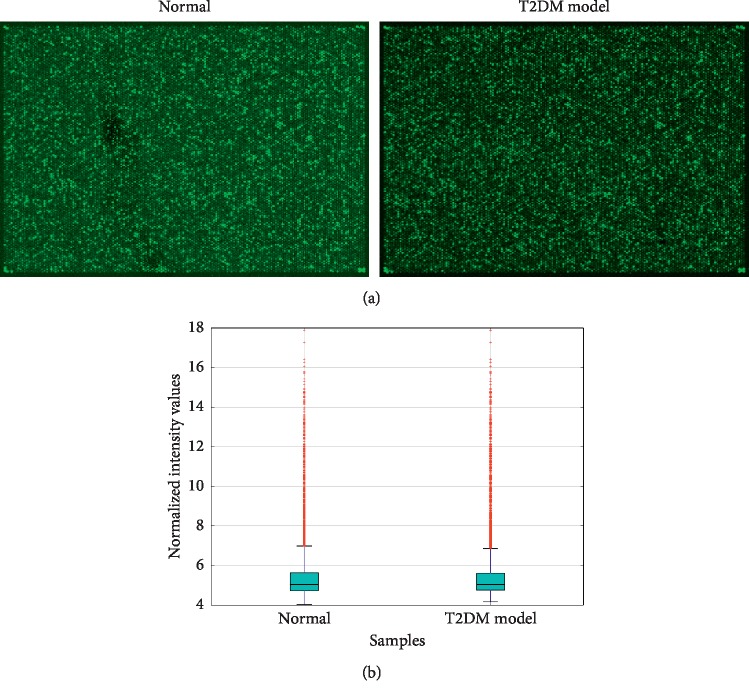
CircRNA microarray expression data between β-cells from normal and T2DM rat islets. (a) The typical results of circRNA microarray from control and T2DM rat islet β-cells. Each bright spot represents a circRNA. (b) Normalized data were plotted as a box plot to determine the overall characteristics of distribution.